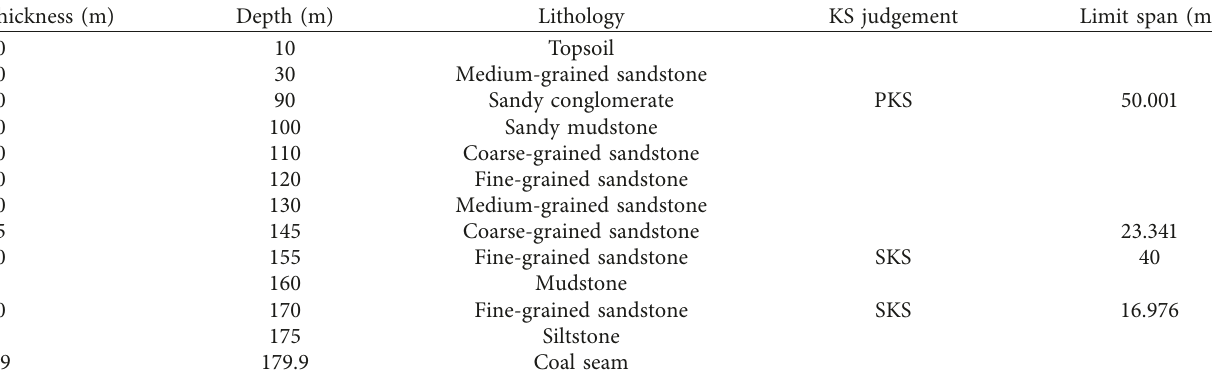
Table 1: Strata thickness and KS location.